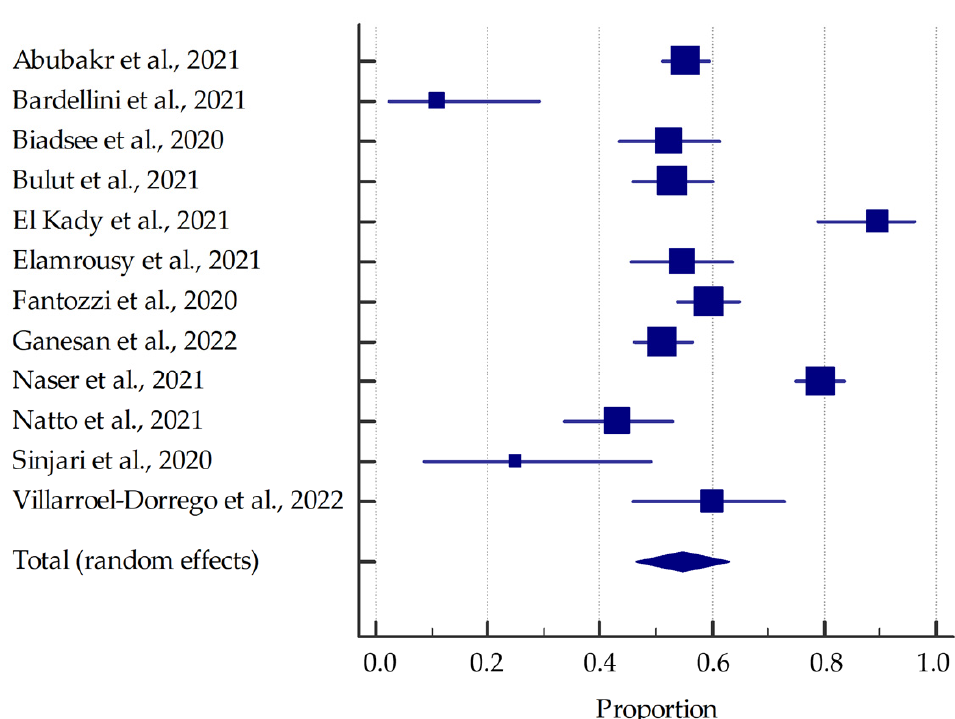
Figure 6. Forest plot presenting the summarized prevalence of taste alterations among SARS-CoV-2 positive individuals.